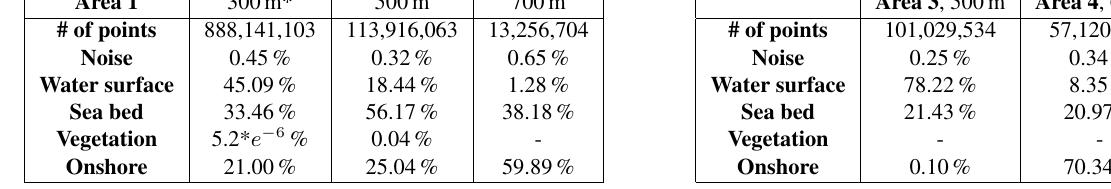
Table 2: Distribution of classes in Area 1 (* area obtained with 300m altitude is smaller).